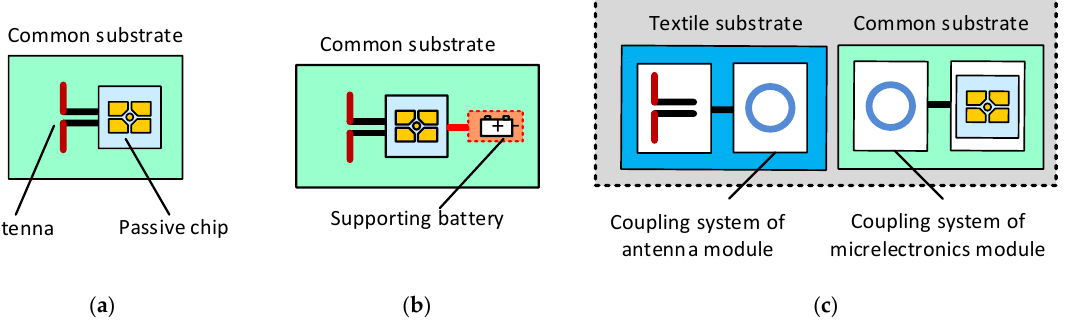
Figure 1. Models of RFID transponders: ( a ) passive transponder; ( b ) semi-passive transponder; ( c ) textronic transponder — RFIDtex tag.